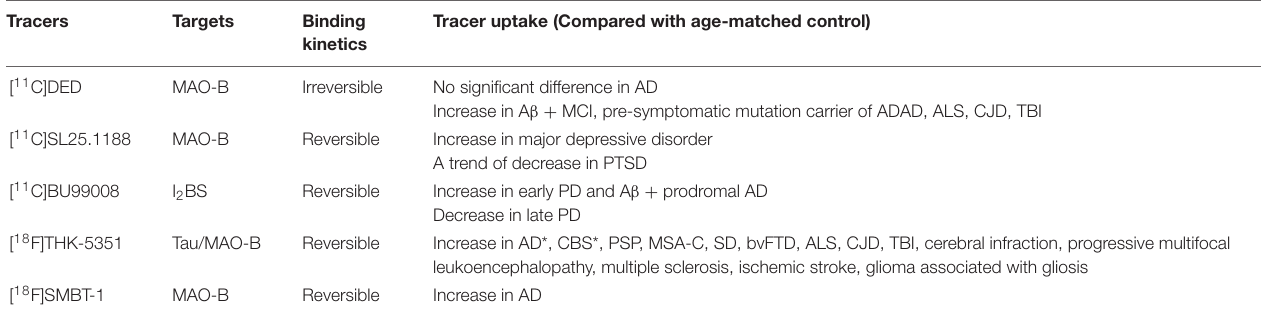
TABLE 1 | Comparison among MAO-B and I 2 BS PET tracers under various conditions in clinical studies. Tracers Targets Binding